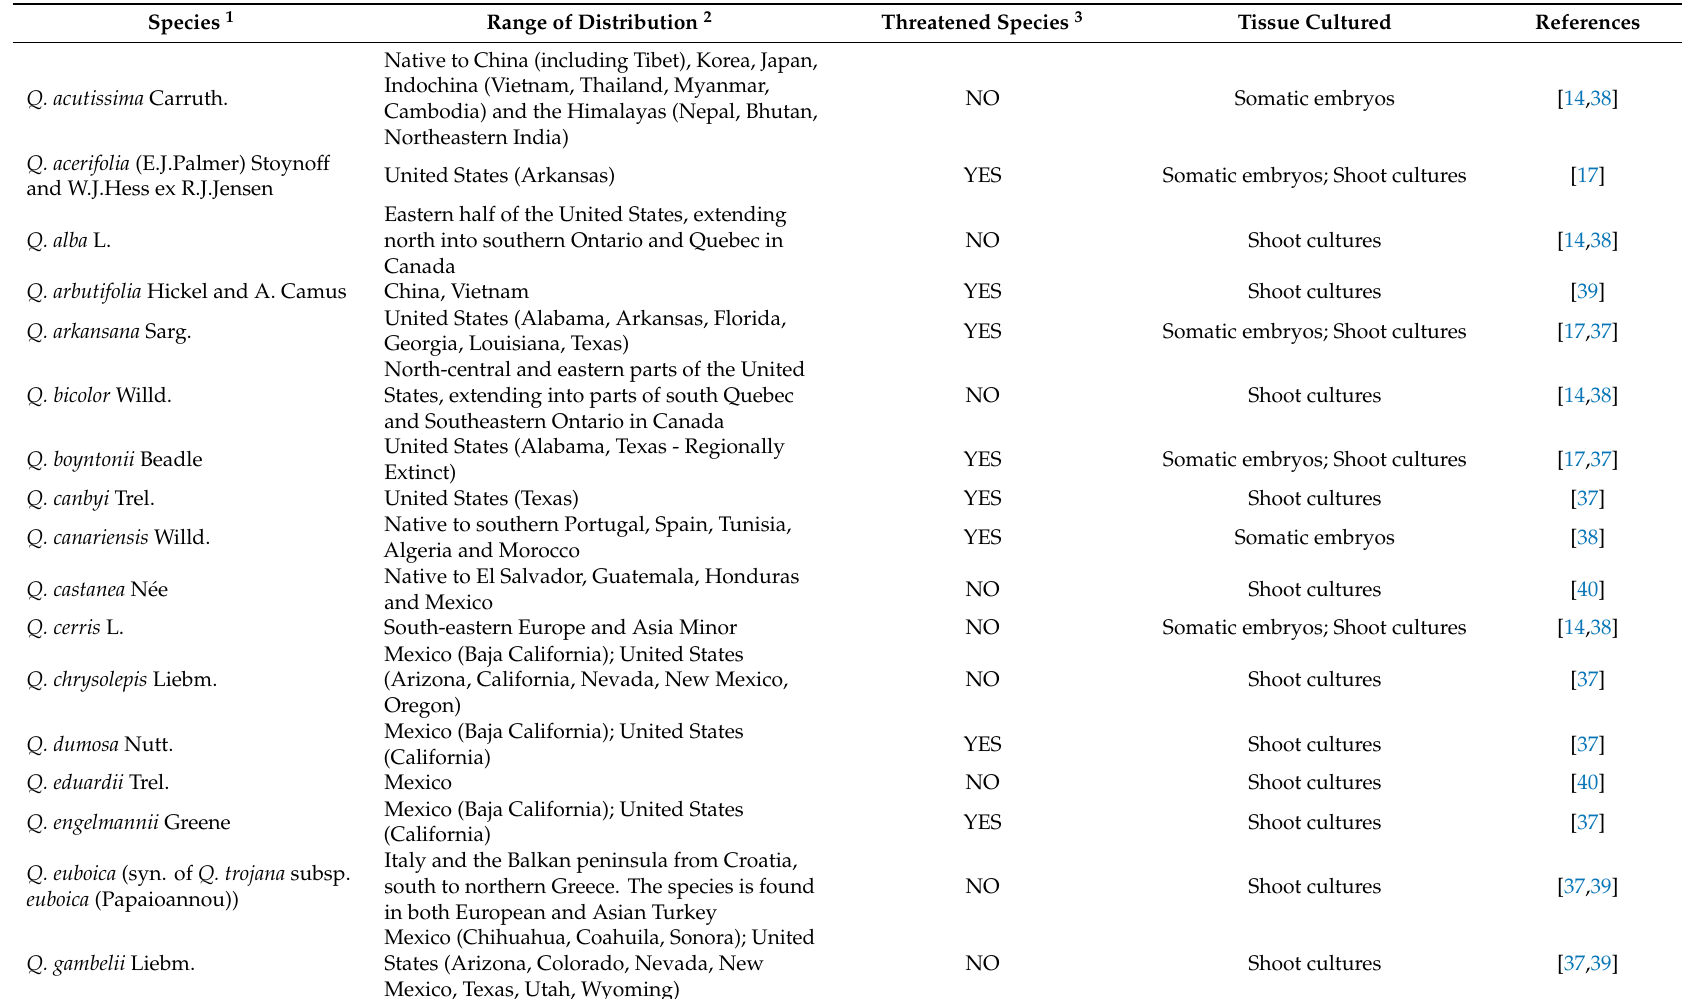
Table 1. Example of Quercus species for which tissue culture have been investigated and